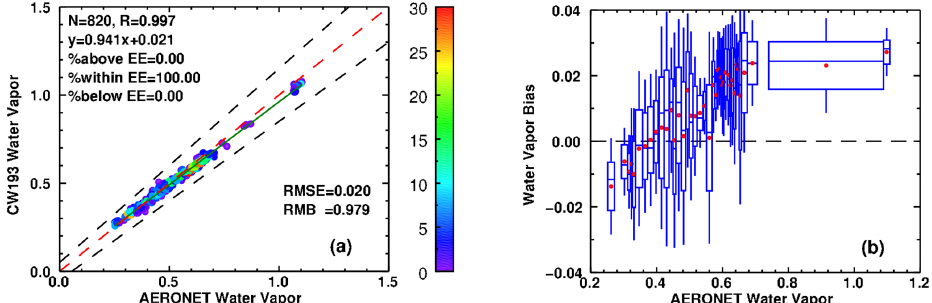
Figure 12. As in Figs. 7 and 8, but for water vapor (unit: